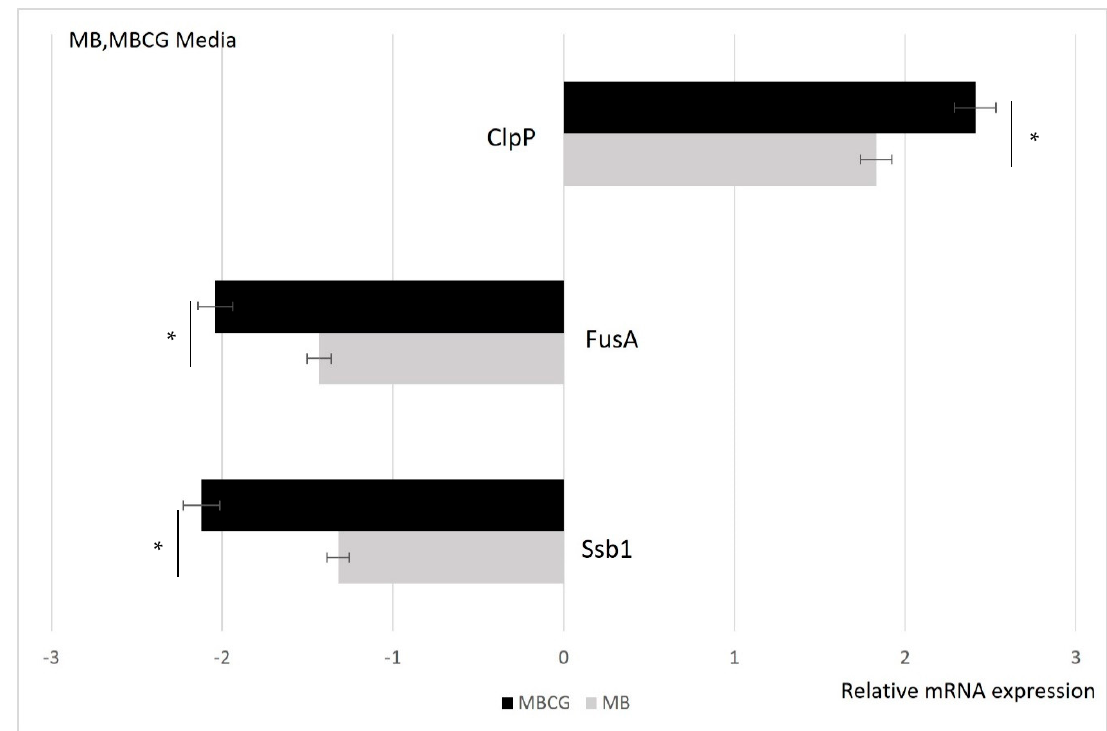
Figure 2. qRT-PCR analysis of the three WK proteins identified in 2DE. Values with an asterisk (*) in the same column are significantly different when compared to those detected in the MB and MBCG media ( p < 0.05).